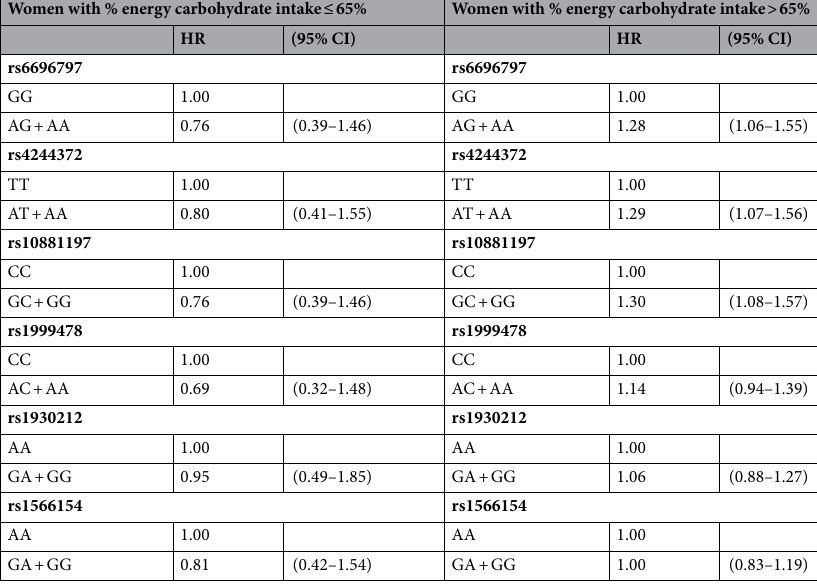
Table 4. Adjusted hazard ratios (and 95% CIs) for associations between AMY1 SNPs and incidence of type 2 diabetes, stratified by carbohydrate intake in Korean women. Adjusted for age (years), area of residence (Ansan or Ansung), education level [elementary school or lower (< 7 years completed), middle/high school (7–12 years), college or higher (> 12 years)], smoking status (never, former smoker, current smoker), alcohol consumption (g/day), physical activity [metabolic equivalent task (MET)-h/week], body mass index (BMI; kg/ m 2 ), and family history of diabetes (self-reports: yes, no). HR hazard ratio, CI confidence